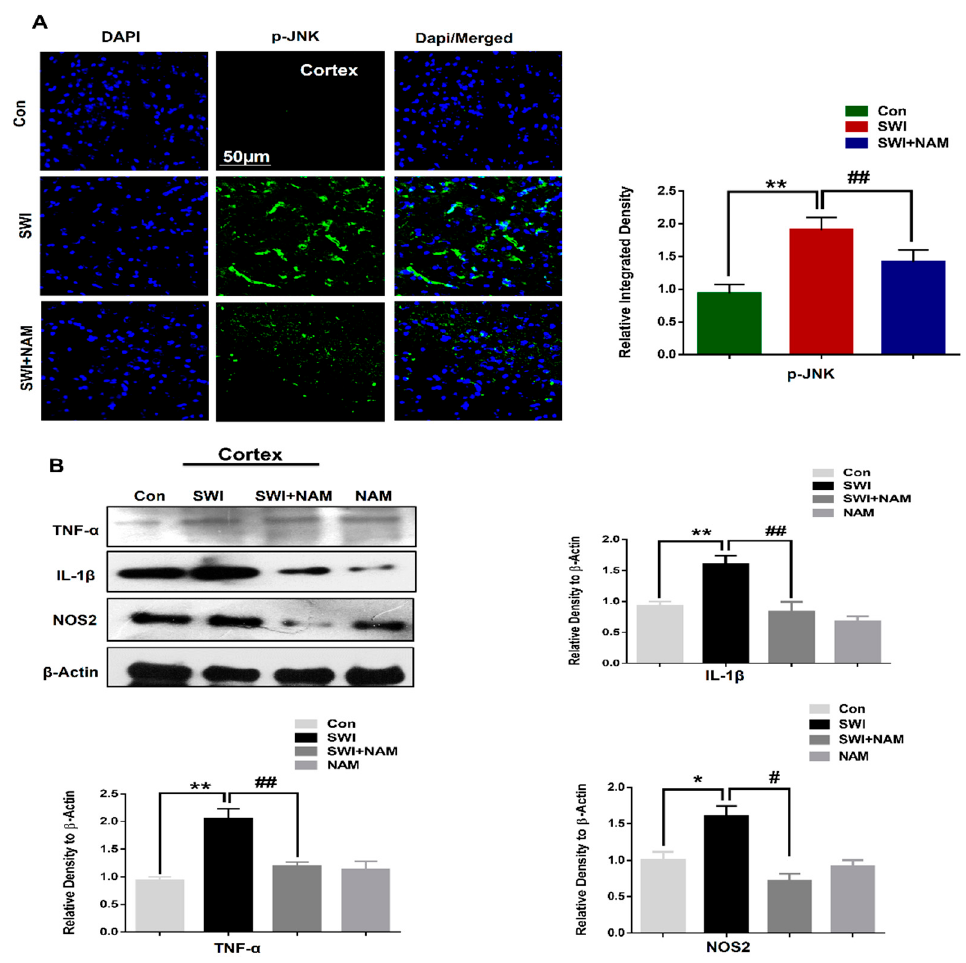
Figure 3. NAM treatment reduced activated JNK and expression level of inflammatory markers in the injured mouse brains. ( A ) The confocal images of p-JNK among the treated mice group, at day 7 ( n = 7). ( B ) The immunoblots and histograms represent the expression levels of pro-inflammatory markers, such as tumor necrosis factor-alpha (TNF α ), interleukin-1 beta (IL1- β ), and nitric oxide synthase 2 (NOS-2) among the treated groups at day 7 ( n = 8). The blots were quantified using sigma gel software. β -actin was applied as a loading control. The ImageJ software was used for histological analysis (Magnification X10). All values were taken from three independent experiments. One-way ANOVA was done, followed by post hoc analysis for the comparison of values. P < 0.05 was considered to be statistically significant. The symbols * P < 0.05, and ** P < 0.01 represent significant differences between the control and the SWI; # P < 0.05, and ## P < 0.01 represent significance differences between the SWI and the SWI plus NAM.